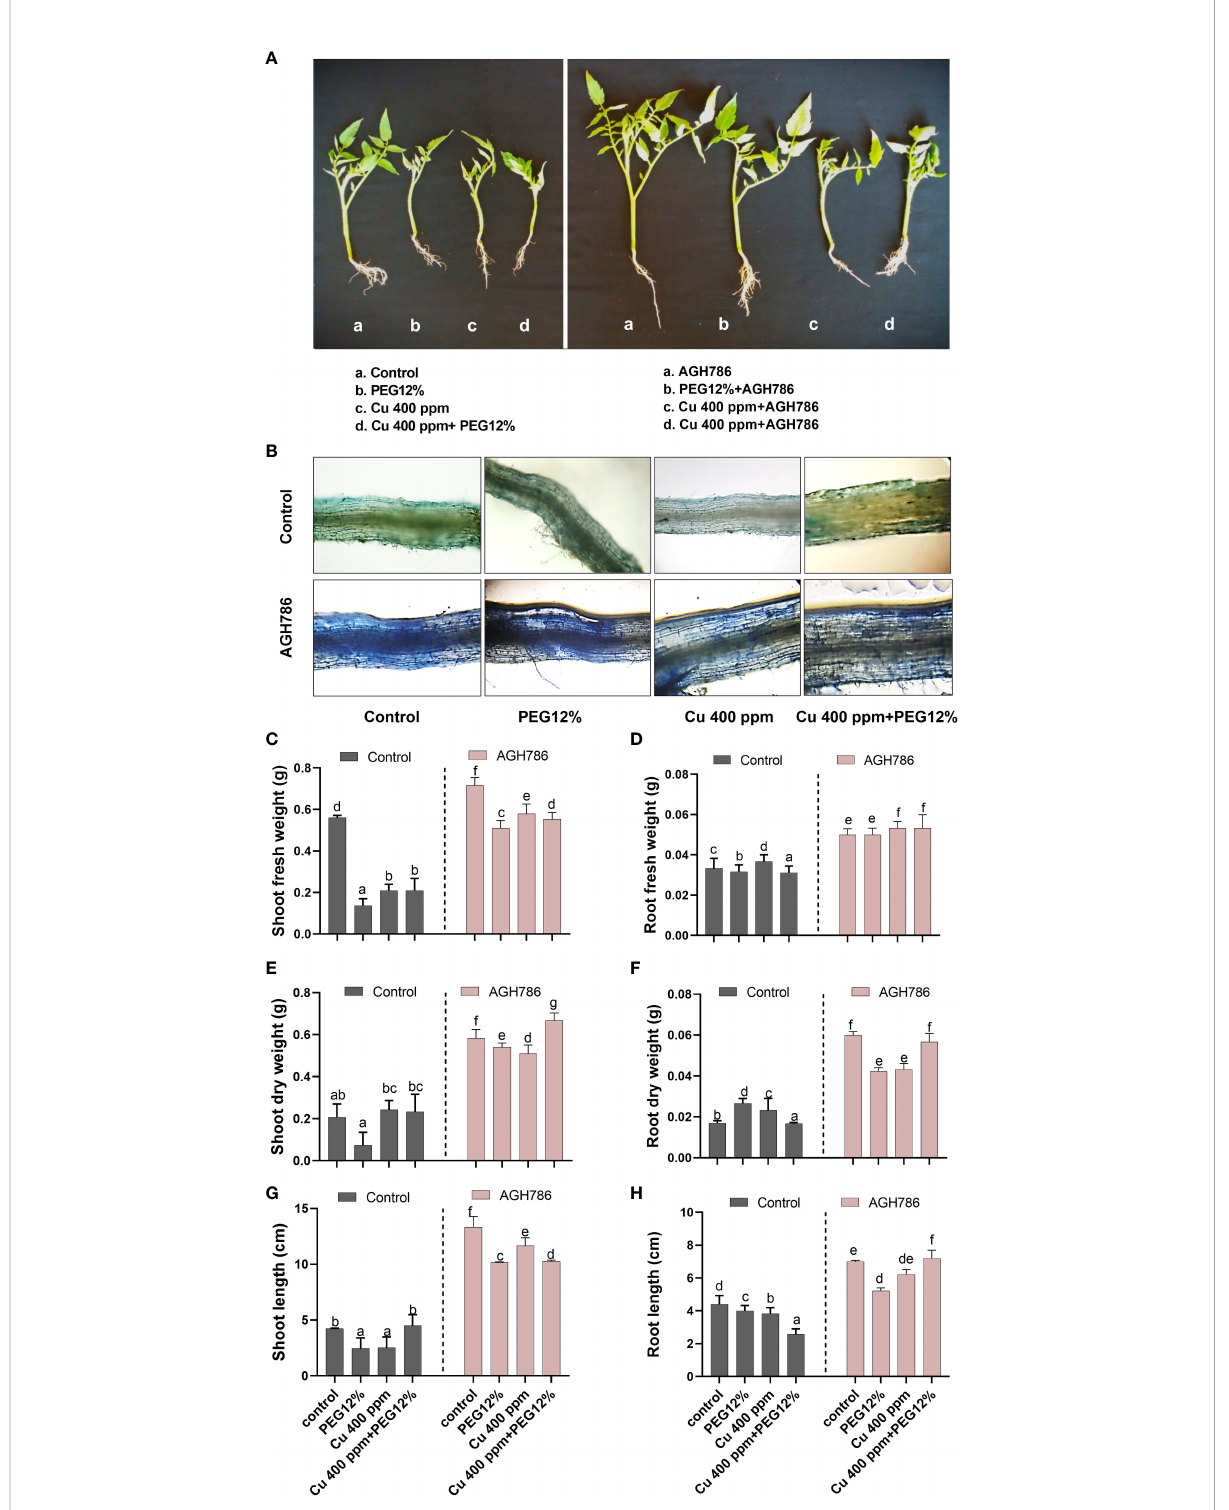
FIGURE 3 Effect of P. spadiceum AGH786 on growth attributes of S. lycopersicum L. under heavy metal (Cu) toxicity and drought stress (12% PEG). (A) Effects of P. spadiceum AGH786 on the growth of host seedlings. (B) Root colonization by P. spadiceum AGH786. (C) Effects of P. spadiceum AGH786 on shoot fresh weight. (D) Root fresh weight. (E) Shoot dry weight. (F) Root dry weight. (G) Shoot length. (H) Root length of host seedlings. Data represent the mean with standard error, and letters represent the signi fi cant difference (p <